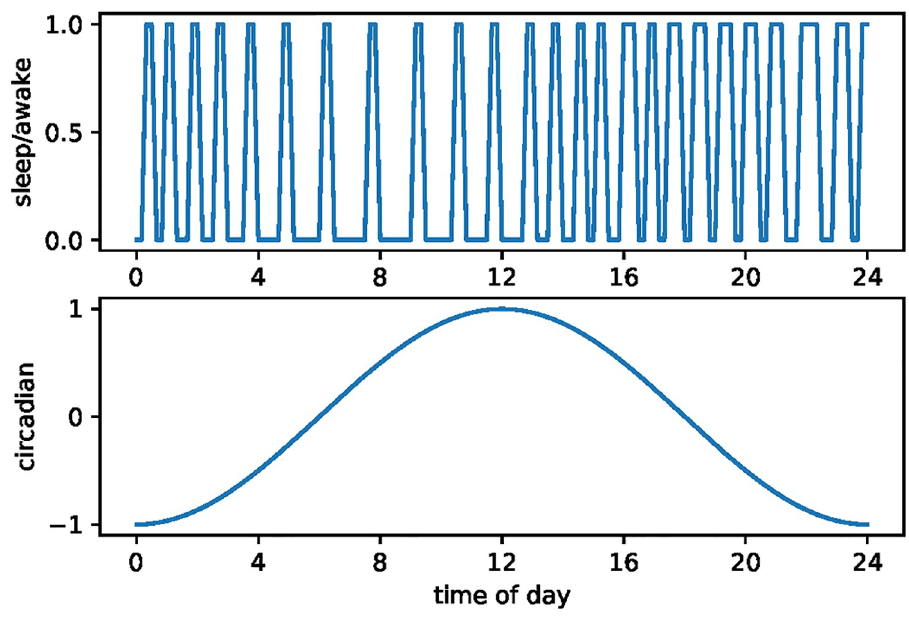
Fig 6. Stylized sloth sleep patterns.